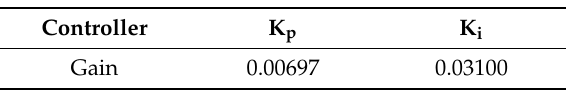
Table 2. The value of the PI controller.